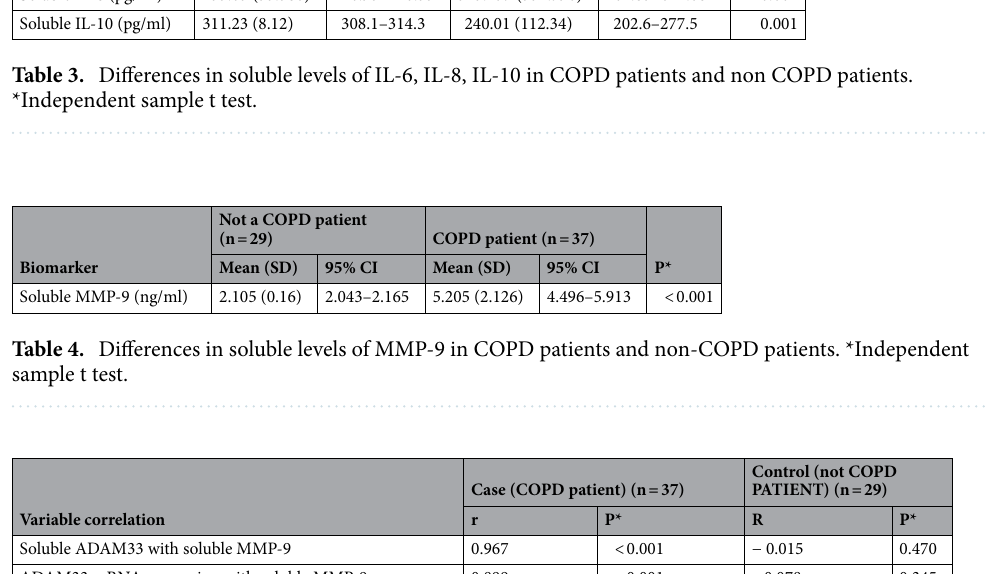
Variable correlation Soluble ADAM33 with soluble